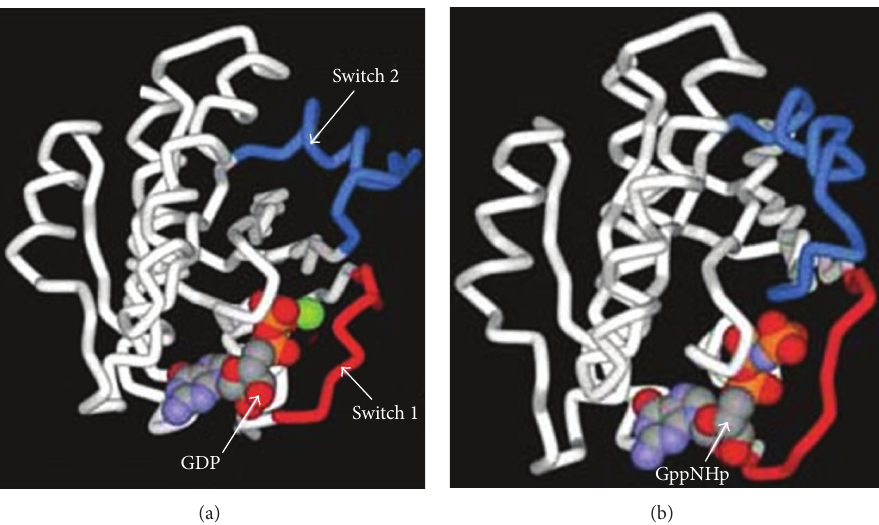
Figure 1: The switch regions of Ras. (a) Ras bound to GDP. This nucleotide is shown as a space-filling structure, with the magnesium ion (based on pdb file 4q21). (b) Ras bound to GppNHp (a nonhydrolysable analogue of GTP also shown as a space-filling structure). When accommodating thelarger nucleotide, theswitch 1region appears to stretchand theswitch 2 region swivels. (Based onpdb file5p21. Reference: NCBI Protein Database).